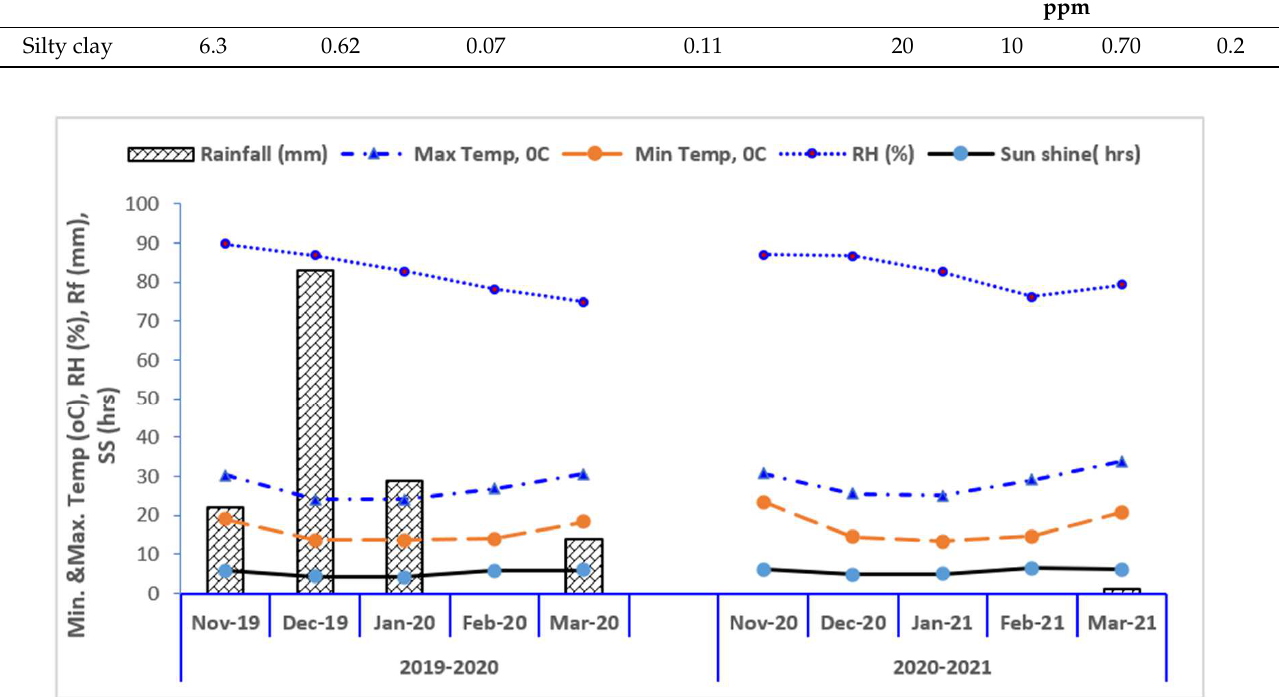
Figure 1. Maximum and minimum mean monthly temperature, relative humidity (RH, %), monthly rainfall (Rf, mm), and sunshine (SS, hour) in 2019–20 and 2020–21.